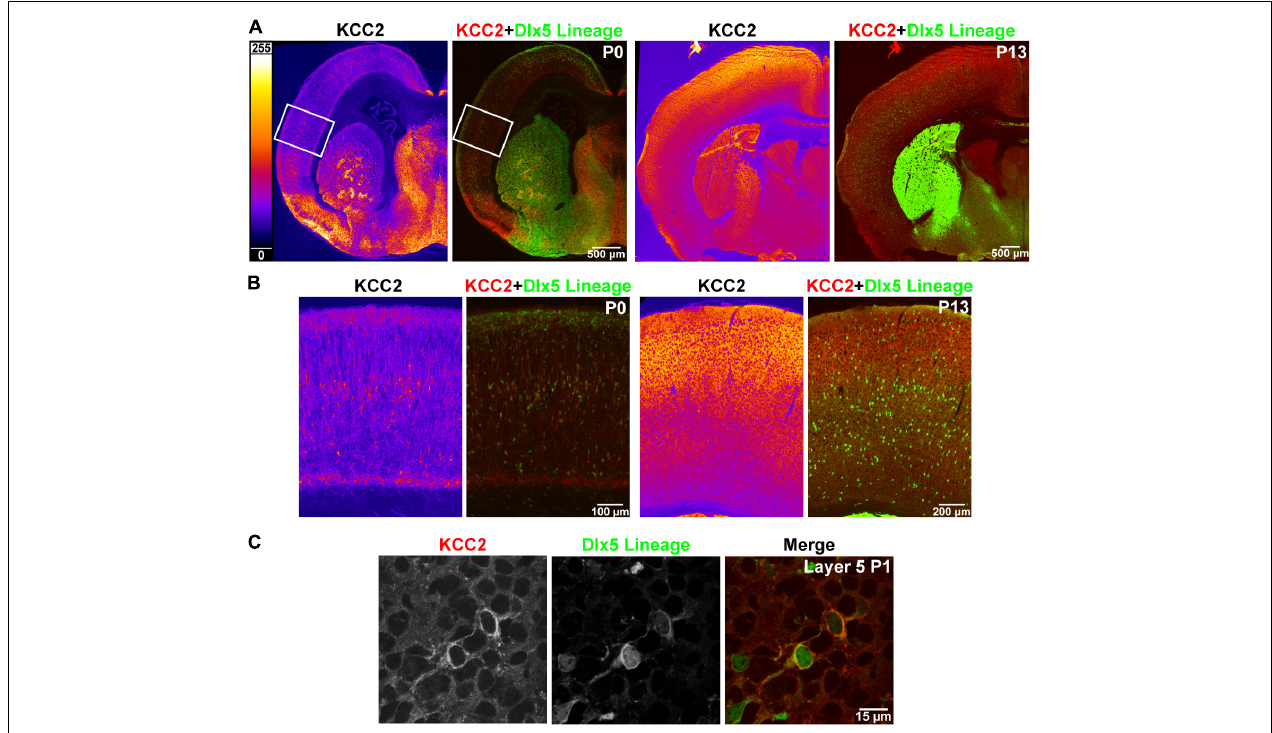
FIGURE 1 | Precocious expression of KCC2 in layer 5 INs. (A) KCC2 immunoreactivity in P0 and P13 WT cortex (orange heatmap images) and its overlay with Dlx5:cre tdTomato reporter, which marks cortical interneurons (KCC2 red, Dlx5 reporter green). (B) Magnified areas of P0 cortex indicated by a white rectangle in (A) and matching images of barrel field cortex at P13. (C) Confocal images from layer 5 showing plasmalemmal KCC2 expression in two WT cells expressing a Dlx5 GFP reporter.